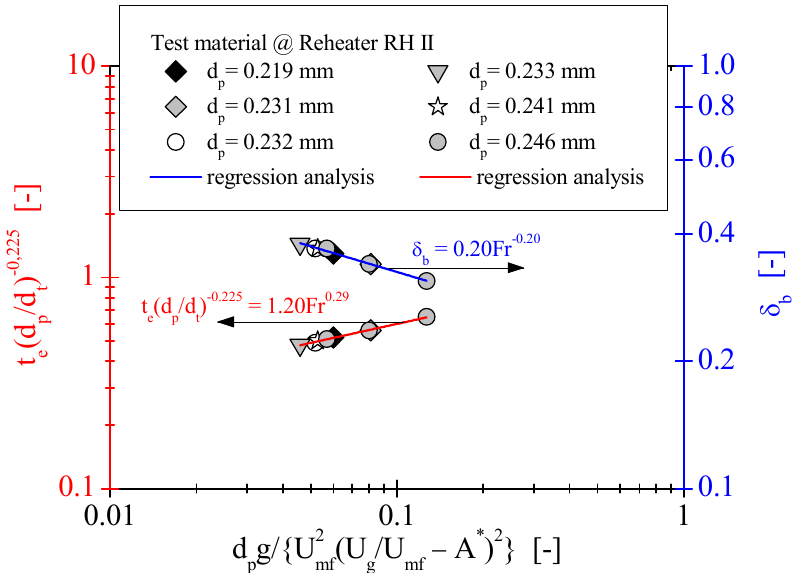
Figure 6. Emulsion phase contacting time and bubble friction for the horizontal smooth tube bundle.